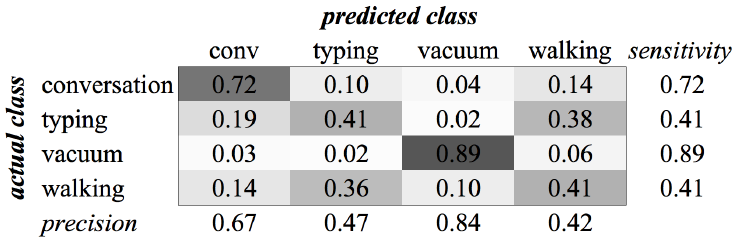
Figure A16. KHMM confusion matrix of category Office for MFCC feature